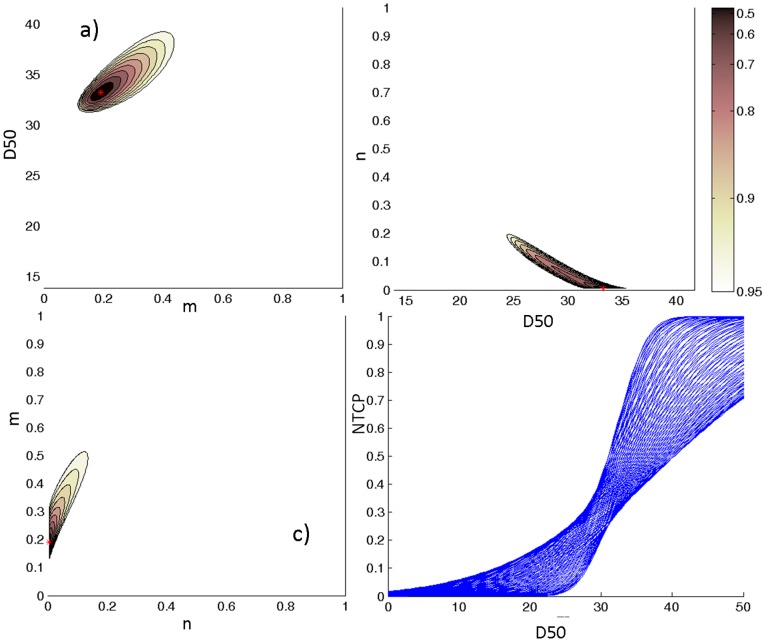
Likelihood estimation values plotted as a function of lung LKB parameters.a) m and D50 for a fixed value of n = 0.01; b) D50 and n for a fixed value of m = 0.19; c) n and m for a fixed value of D50 = 33.2; d) NTCP bundle of curves showing 95% confidence interval for the model fit. The red point corresponds to the optimum LLH. Abbreviation- LKB: Lyman-Kutcher-Burman, D50: uniform dose given to the entire organ volume that results in 50% complication probability, NTCP: Normal Tissue Complication Probability, LLH: Log-likelihood.